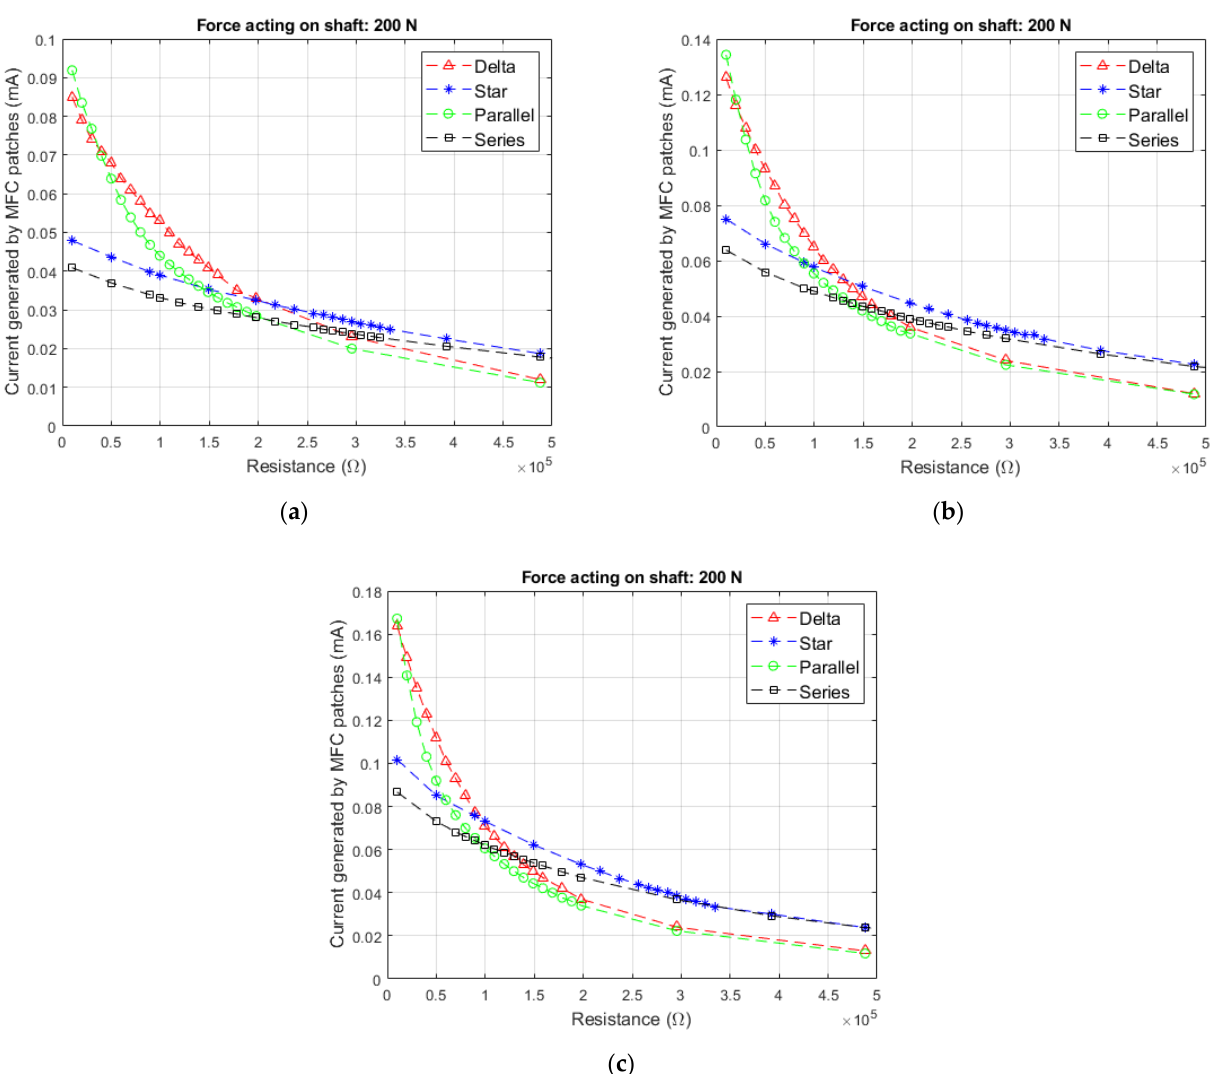
Figure 5. Current generated for a force equal to 200 N: ( a ) rotational speed equal to 10 rps; ( b ) rotational speed equal to 15 rps; and ( c ) rotational speed equal to 20 rps.